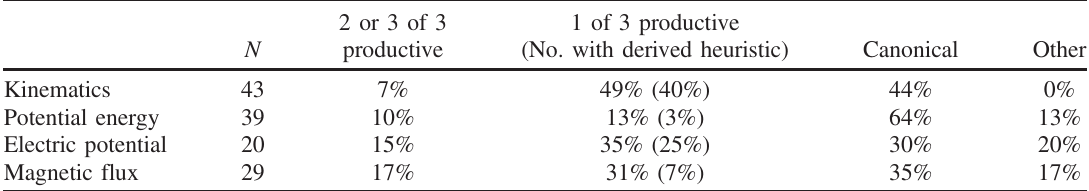
TABLE V. Incorrect reasoning chain categories (experiment 2B). Values shown are percentages of those responses in support of time B. Total number of time B responses is indicated for each